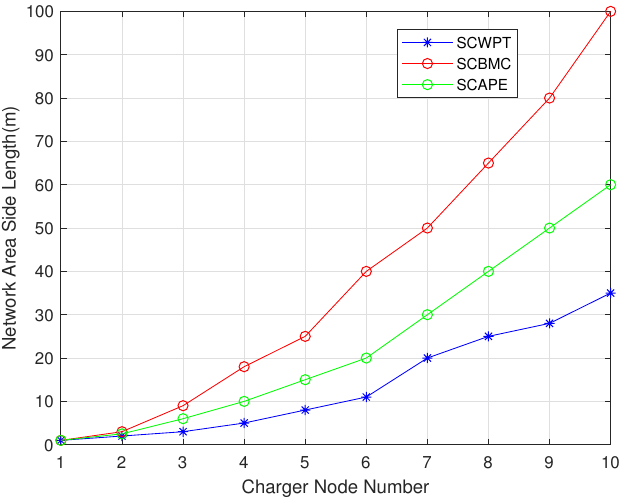
Figure 22. Comparison between SCBMC, SCWPT and SCAPE about network area expansion.